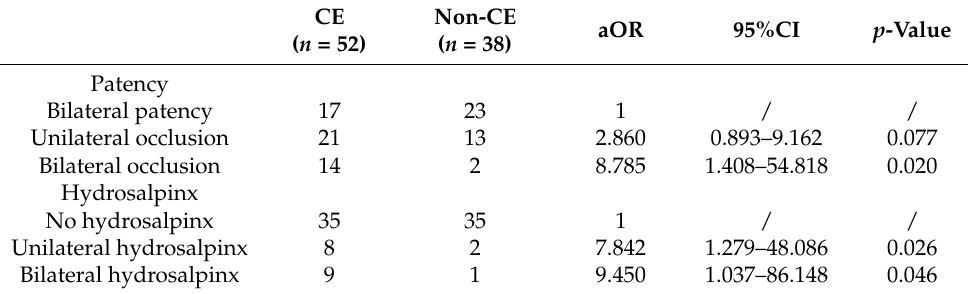
Table 3. Comparison of tubal factors between CE and non-CE